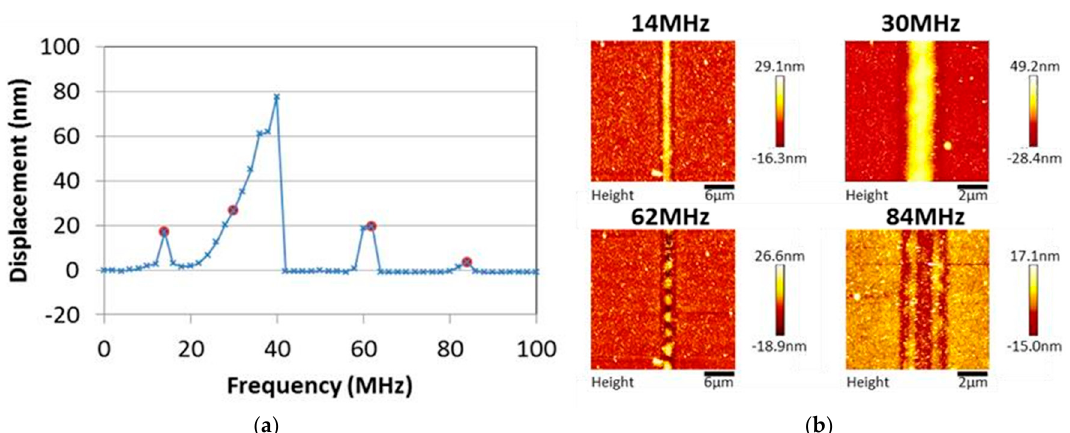
Figure 4. Resonances at high excitation of a 2.3 μ m wide device with a A-type membrane with natural frequency f 0 = 26 MHz: ( a ) spectrum measured for V dc = 15 V, v ac = 5 V. Bullets indicate the frequencies corresponding to the scans shown in ( b ) Amplitude of vibration around 40 MHz is 80 nm on a 2.3 μ m large suspended width; ( b ) amplitude scans taken when biased with V dc = 15V, V ac = 5 V at frequencies 14 MHz and 62 MHz on a 30 μ m × 30 μ m area, at frequencies 30 MHz on a 10 μ m × 10 μ m area, and at. 84 MHz on a 8 μ m × 8 μ m